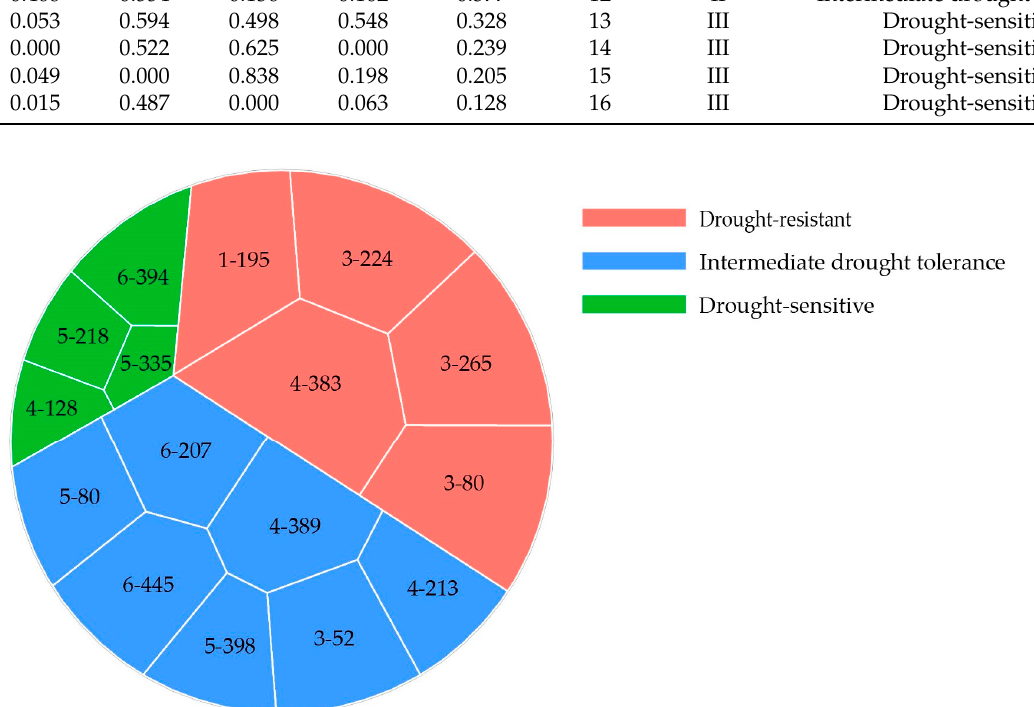
Figure 2. Polygonal tree cluster diagram of drought resistance in the tested families based on the D value. Different colors represent families with different drought resistance. Polygon area represents the D value size.